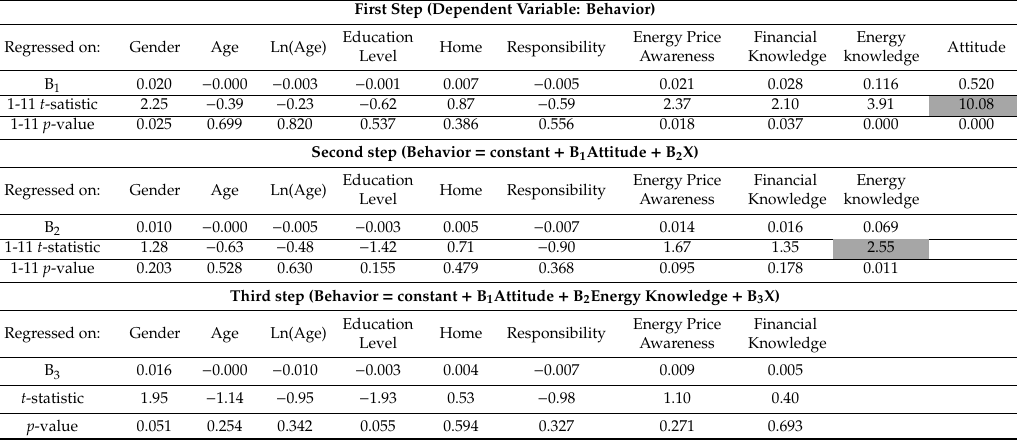
Table A3. Stepwise estimations considering behavior as a dependent